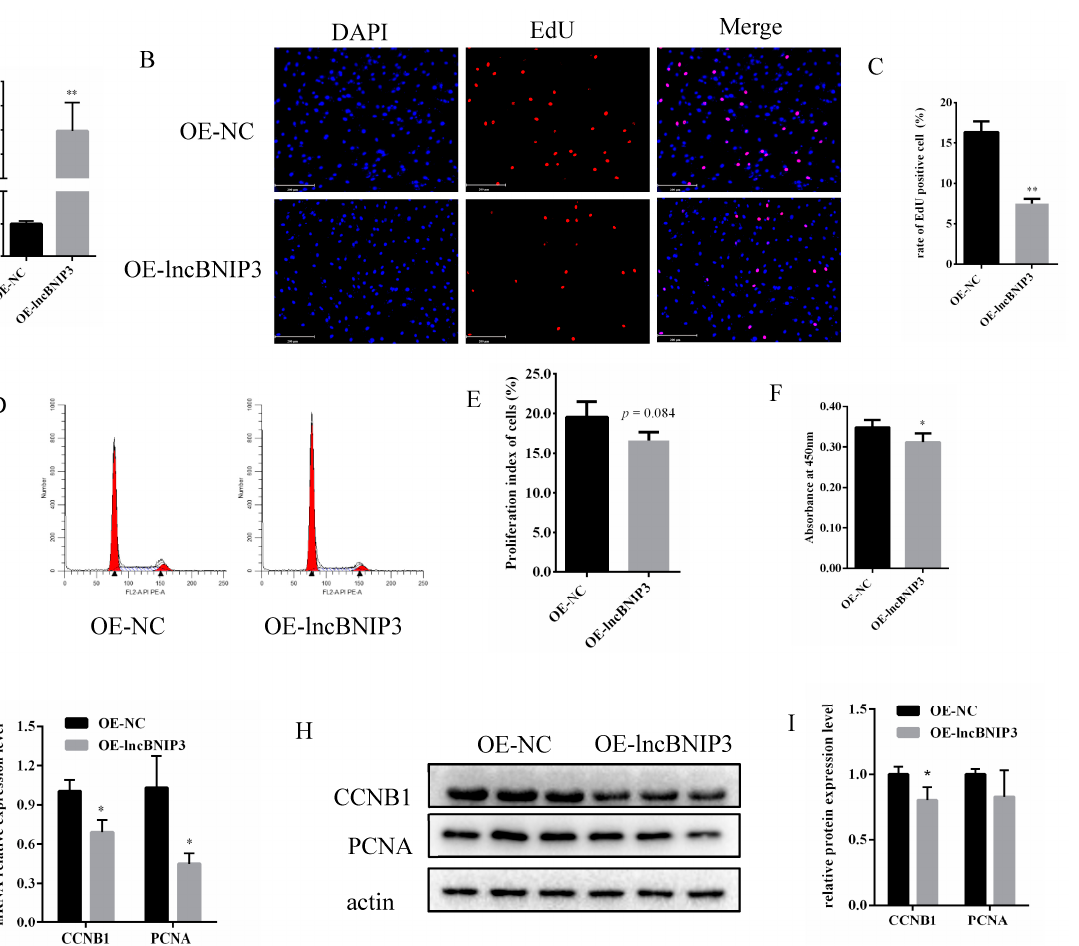
Figure 3. Overexpression of lncBNIP3 inhibited the proliferation of bovine intramuscular preadipocytes. ( A ) The efficiency of lncBNIP3 overexpression; ( B ) The EdU staining results (200×), scale bar: 200 μ m; ( C ) Statistical data of the EdU results; ( D ) Flow cytometry results; ( E ) Statistical data of the flow cytometry results; ( F ) The results of CCK8; ( G ) The expression levels of CCNB1 and PCNA in mRNA levels; ( H ) Western Blot results of CCNB1 and PCNA; ( I ) Statistical data of the Western Blot results. Data are expressed as means ± SD. ** indicated extremely significant difference ( p < 0.01), * indicated significant difference ( p < 0.05). 2.4. Identification and Enrichment Analyses of DEGs Associated with lncBNIP3 To further explore the lncBNIP3 mechanism on the proliferation of intramuscular preadipocytes, RNA-seq was performed after interference with lncBNIP3 for 48 h. First, the results of Principal Component Analysis (PCA) and Pearson Correlation Coefficient analysis between samples showed that the control group and the treatment group were grouped into two separate clusters (Figure 4A,B), indicating that biological duplication met the requirements of subsequent analysis. Next, we analyzed gene expression differ- ences between groups, and a total of 660 differentially expressed genes (DEGs) satisfying the conditions ( P adj < 0.05 and log2 (fold change) > 1) were obtained, including 417 up- regulated DEGs and 243 down-regulated DEGs (Figure 4C). In addition, the heatmap analysis was conducted according to the expression of DEGs (Figure 4D), and the gene expression difference multiples and q-value between the two groups were shown (Figure